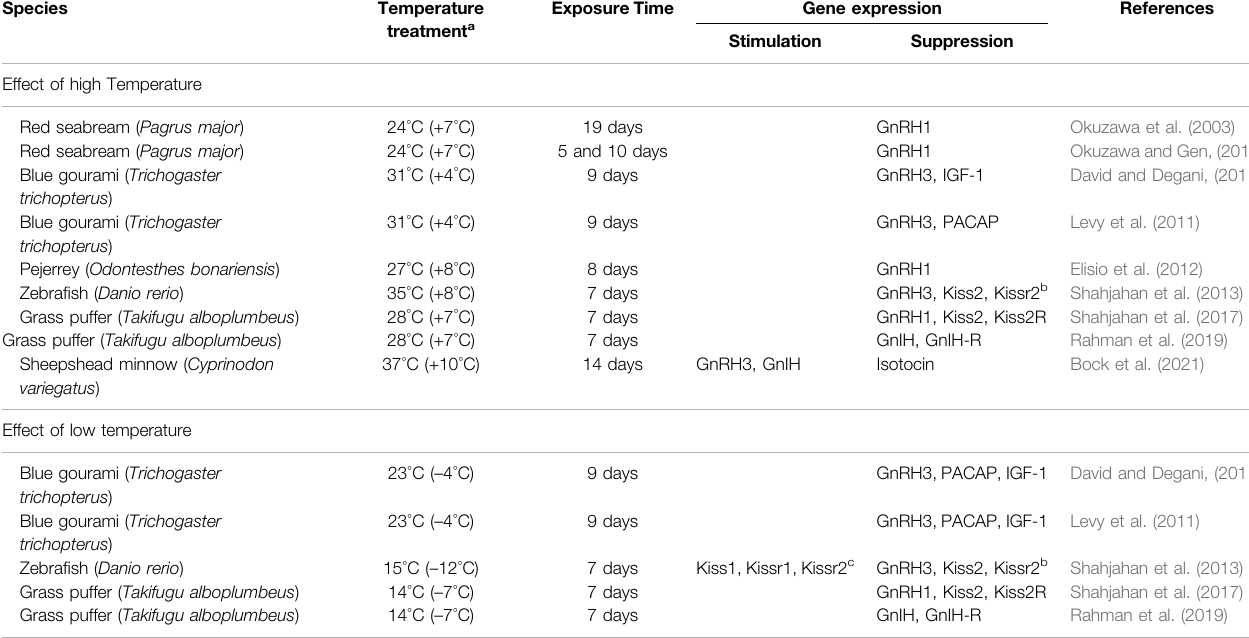
TABLE 1 | Effects of water temperature on the brain of fi sh.